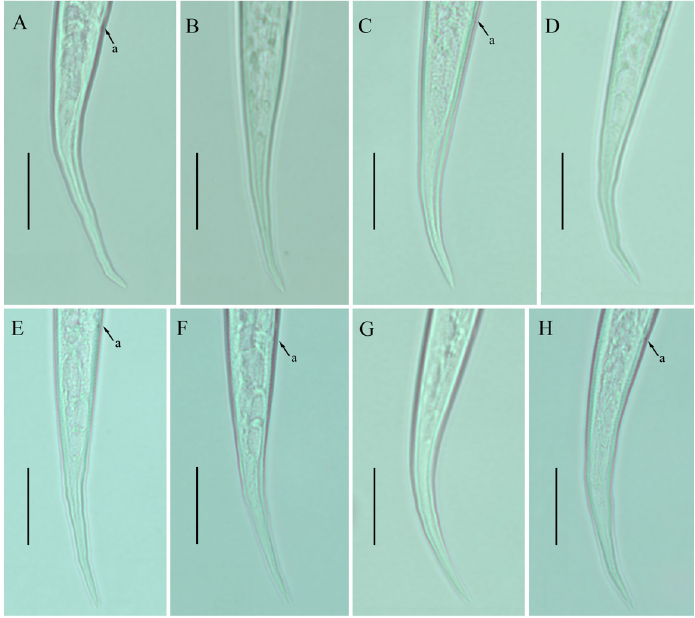
Figure 6. Photomicrographs of female Ditylenchus valveus Thorne and Malek [31] tail region variations ( A – H ) tail terminus rounded to pointed. Scale bars: 20 µm. Arrows: (a) anus.